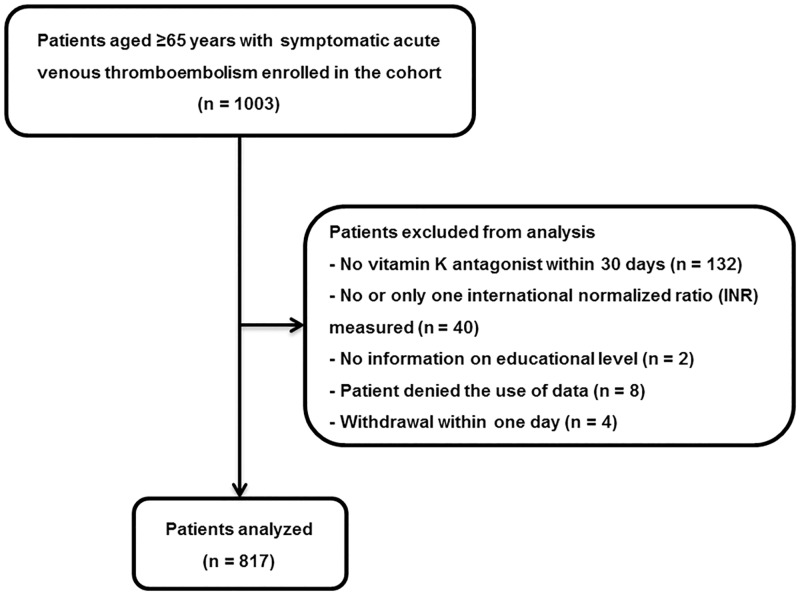
Patient flow chart.